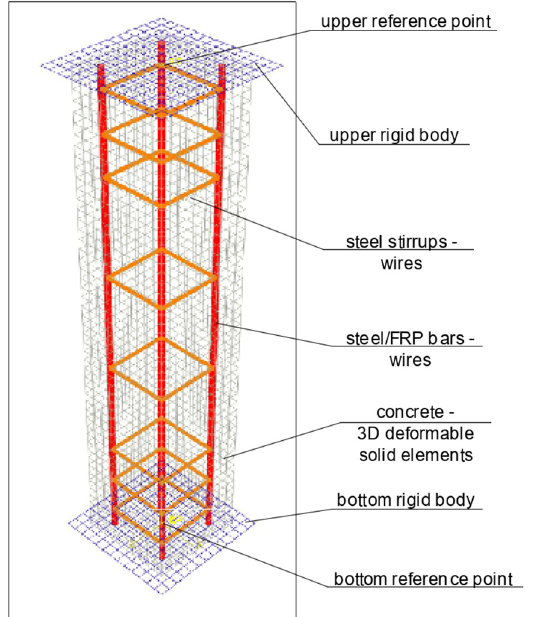
Figure 4. Model of the specimen created for the purpose of nonlinear analysis in the ABAQUS program.